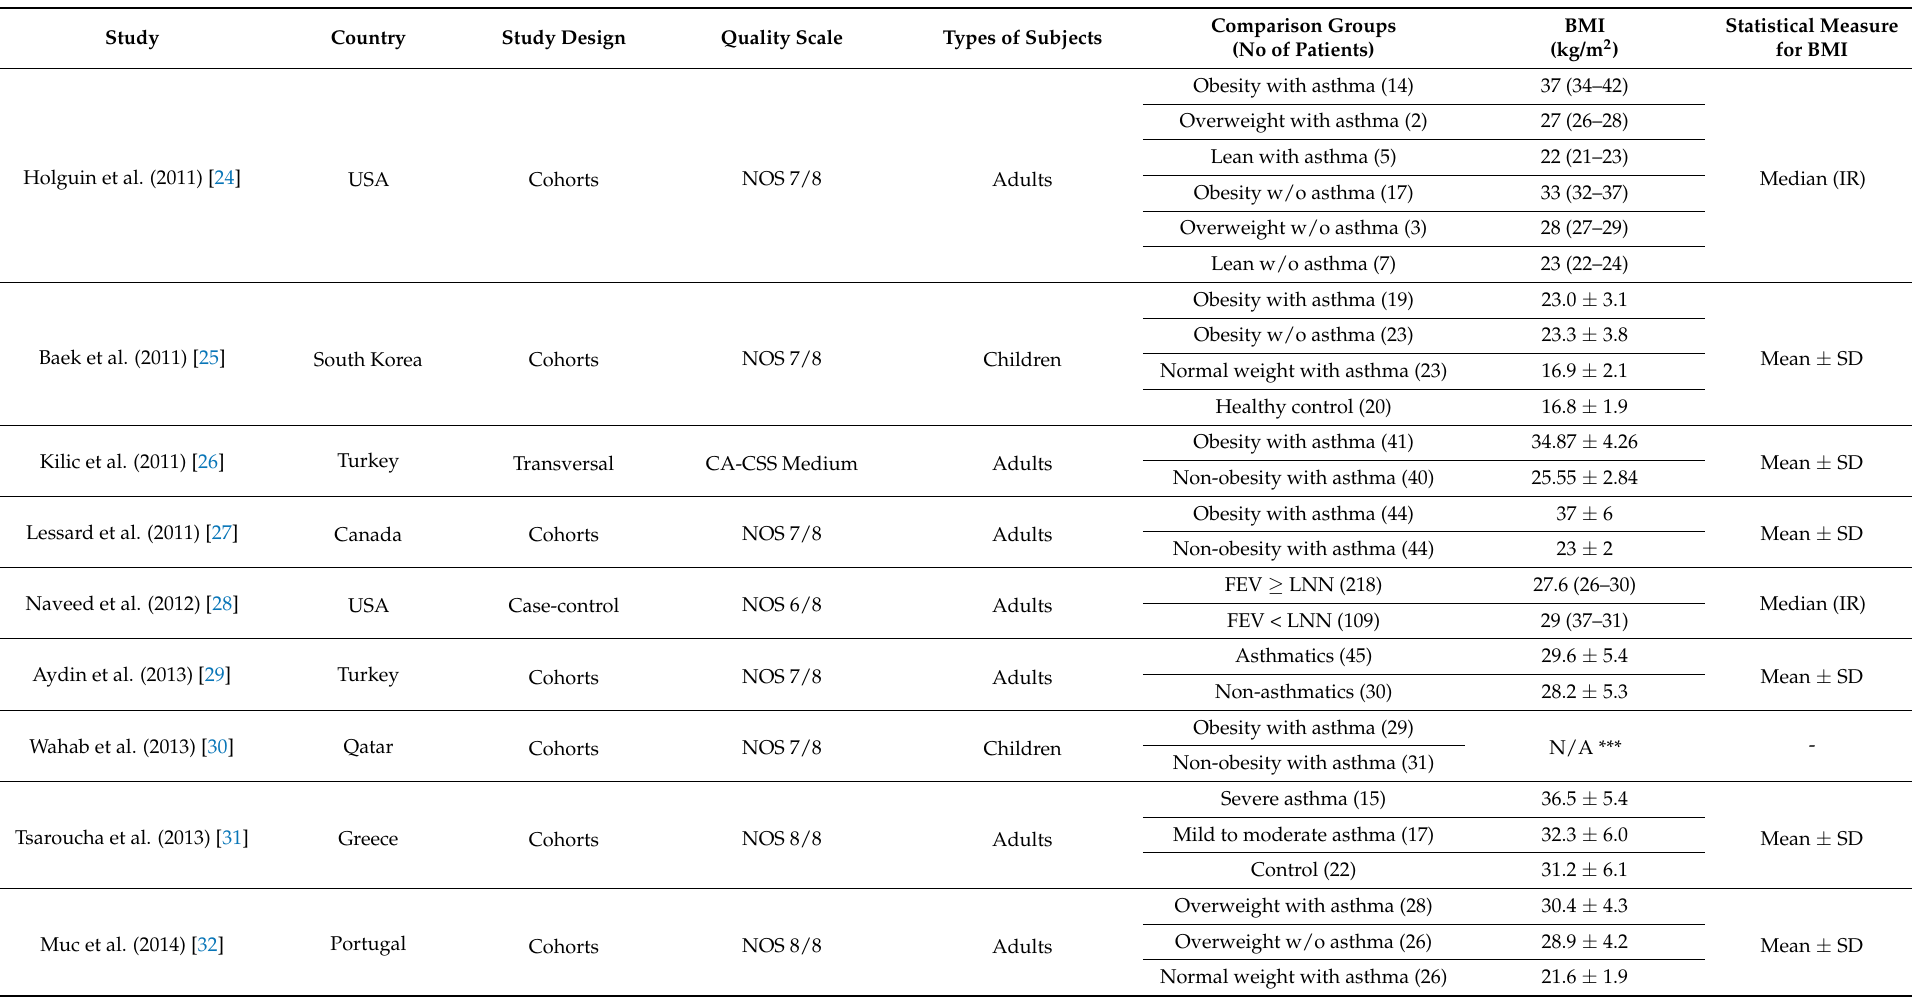
Table 1. General characteristics of the fifteen studies analyzed. * There were no distinctions between groups to measure BMI. It also included other